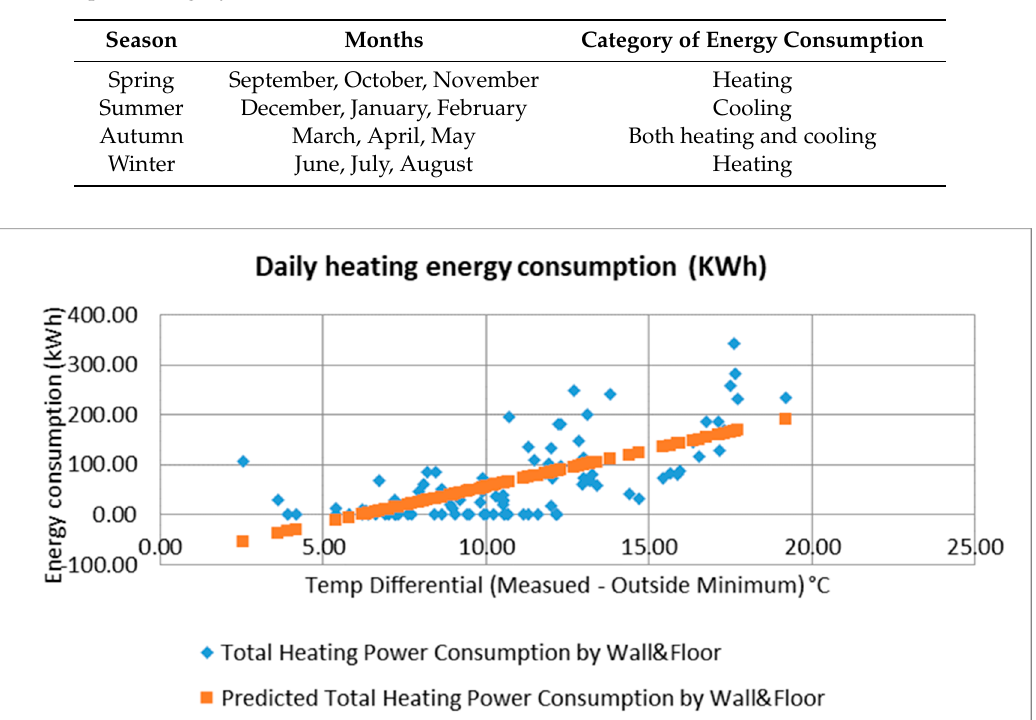
Figure 8. Comparison of total energy consumption and temperature differentials. Daily total energy consumption vs. temperature differential (outside average—measured in the greenhouse). Daily energy consumption was a function of temperature differentials, so regressions of energy consumption with temperature differential were conducted for spring, summer and autumn (Table A7). Based on the regressions of daily energy consumption in each season, energy consumption was 14.62 KWh per 1 °C of heating and 2.23 KWh per 1 °C of cooling. In order to compare total energy consumption during these seasons, descriptive statistics were evaluated and shown in Table 4. Using a pad and fan system for cooling, the facility in summer used the least amount of energy, while, in spring, it used the most energy. 3.6. Analysis of Crop Production The capsicum crop was planted on 30 August 2017, and the final harvest occurred on 4 May 2018. Initial harvesting began on 11 November 2017, approximately 80 days after planting, and continued for about 6 months (180 days). The results show that the harvesting period of the crop is significantly longer than that in field crop production [28,29]. During the harvest period (8/9/2017–